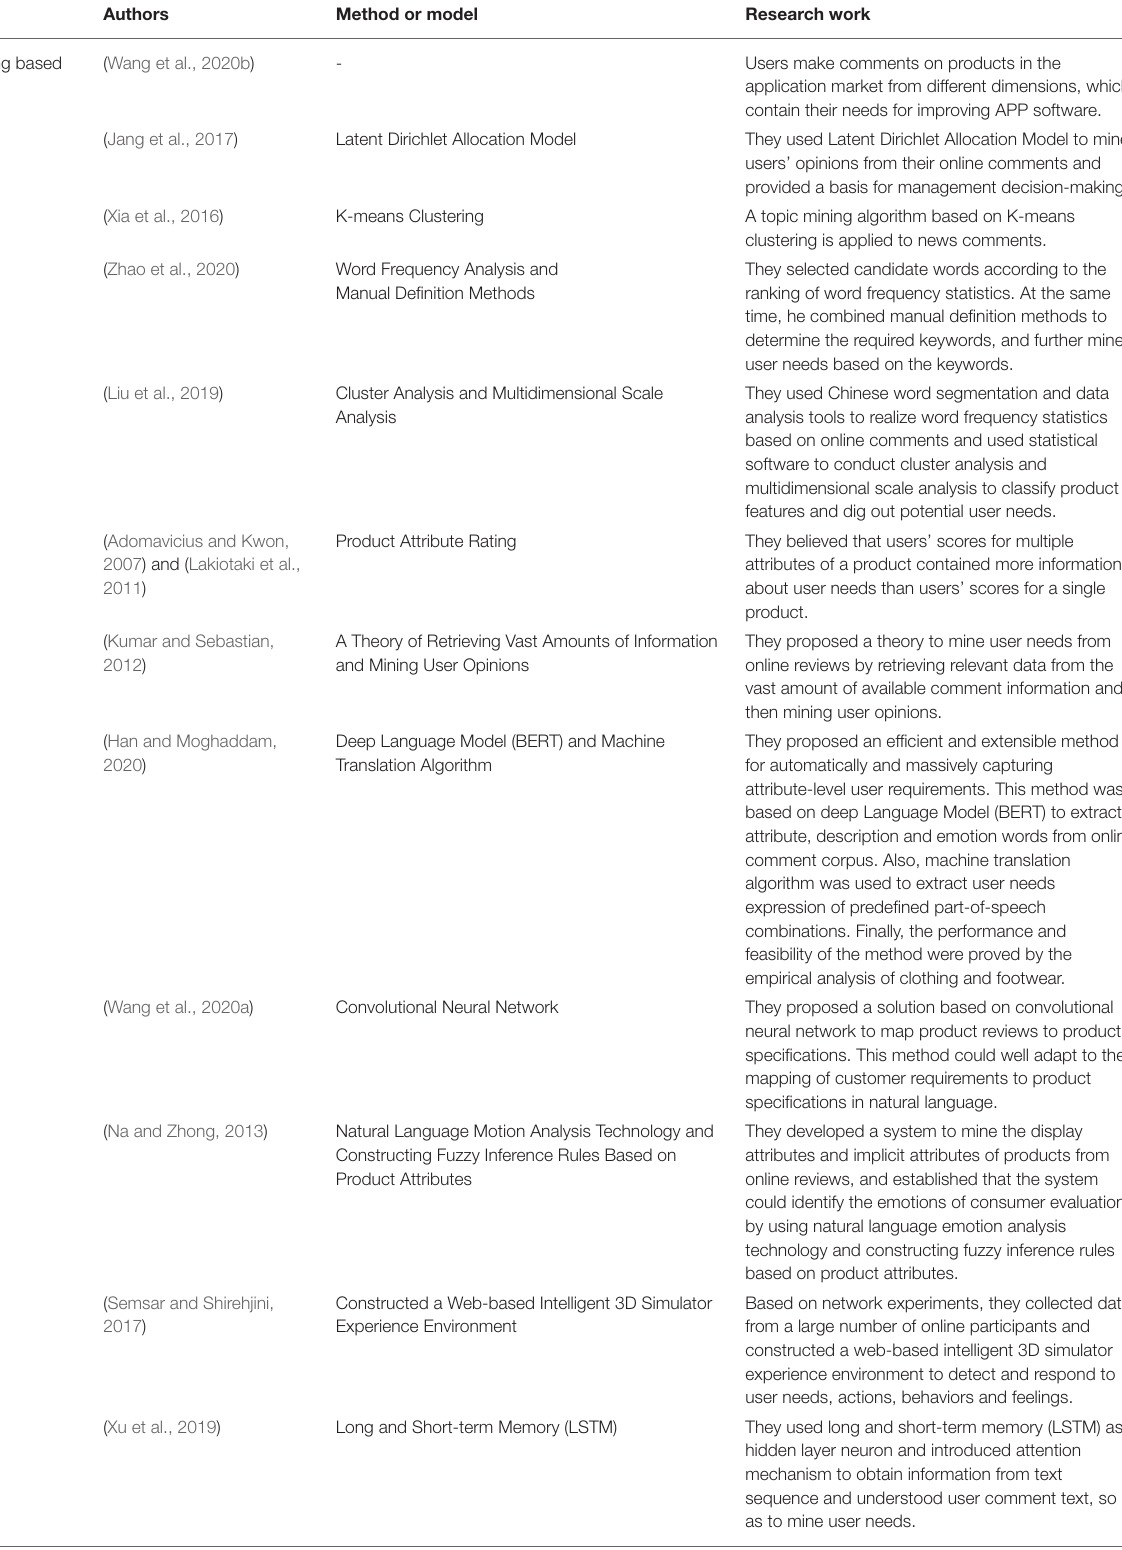
TABLE 2 | Review of methods for mining user needs based on online comments.